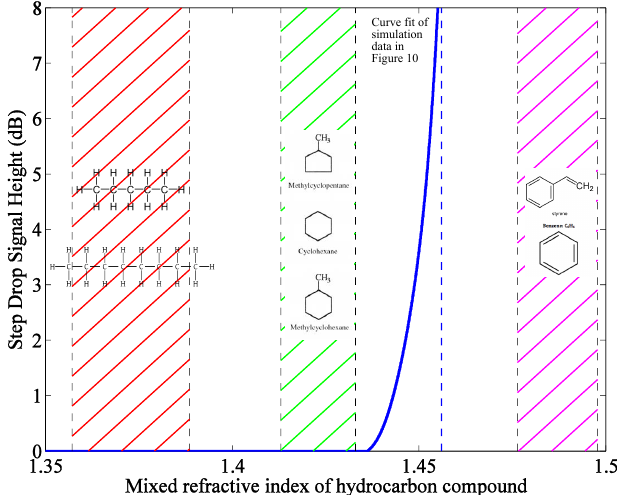
Figure 12. Calibration plot obtained for current sensor configuration with reference to known hydrocarbon compounds present in crude oil